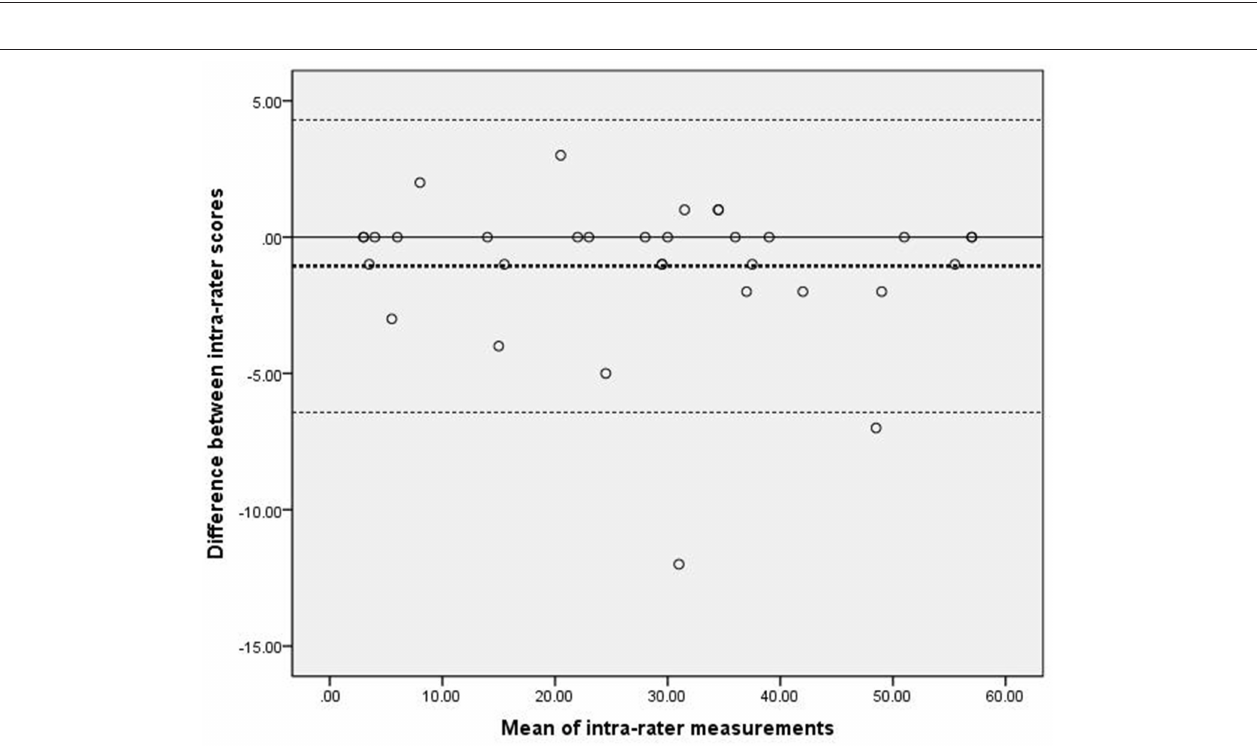
FIGURE 2 | Scatter-plots of the differences between two measurements by the same rater. The dashed bold line represented the mean difference score. The dashed lines represented the limits of agreement (mean ± 1.96 × the standard deviation of the different score).